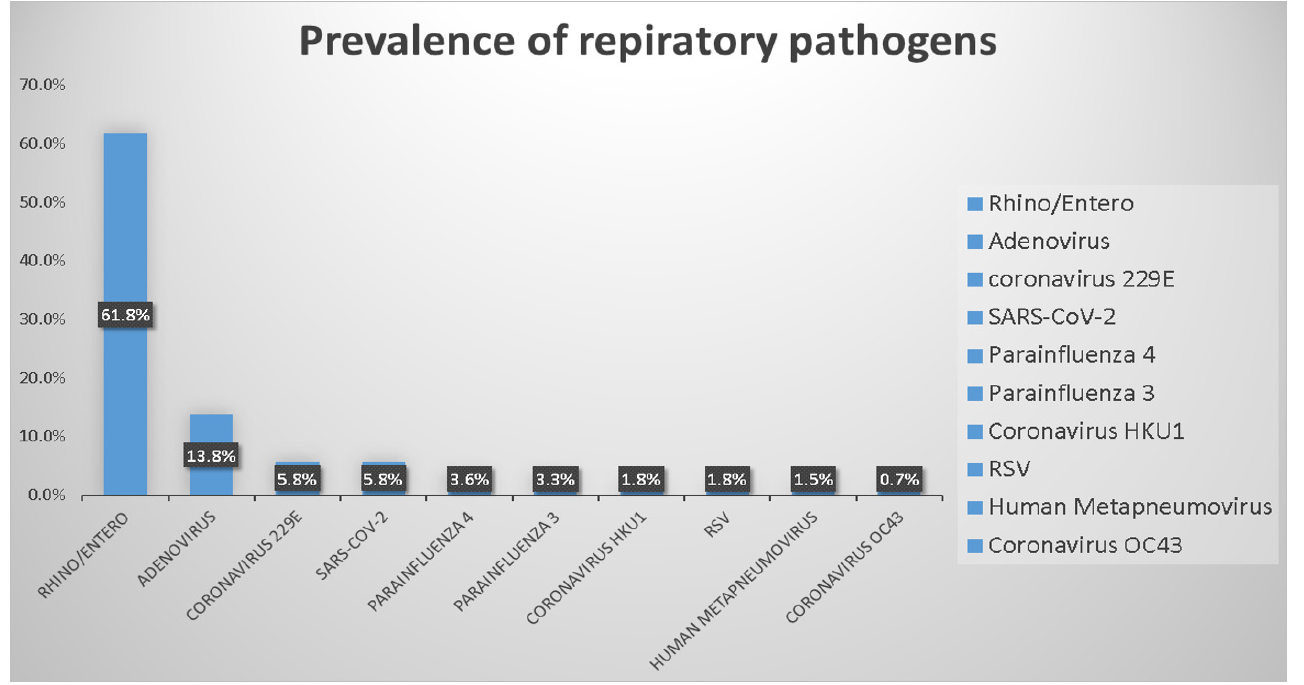
Figure 1. Prevalence of respiratory organisms detected by FilmArray TM RP assay.